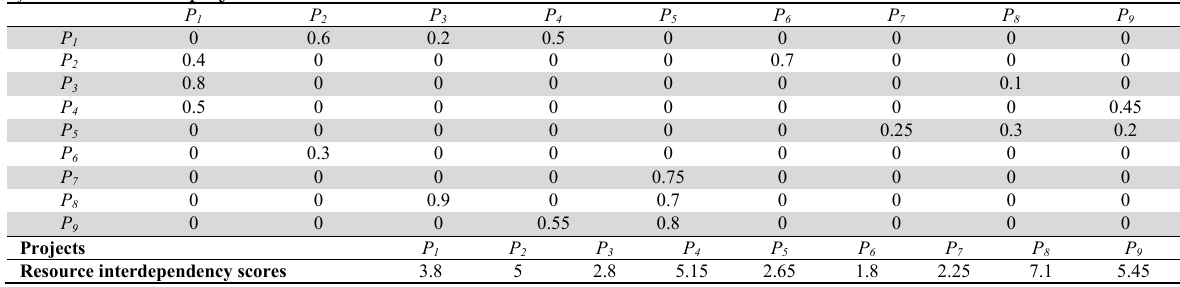
r ij values matrix of projects